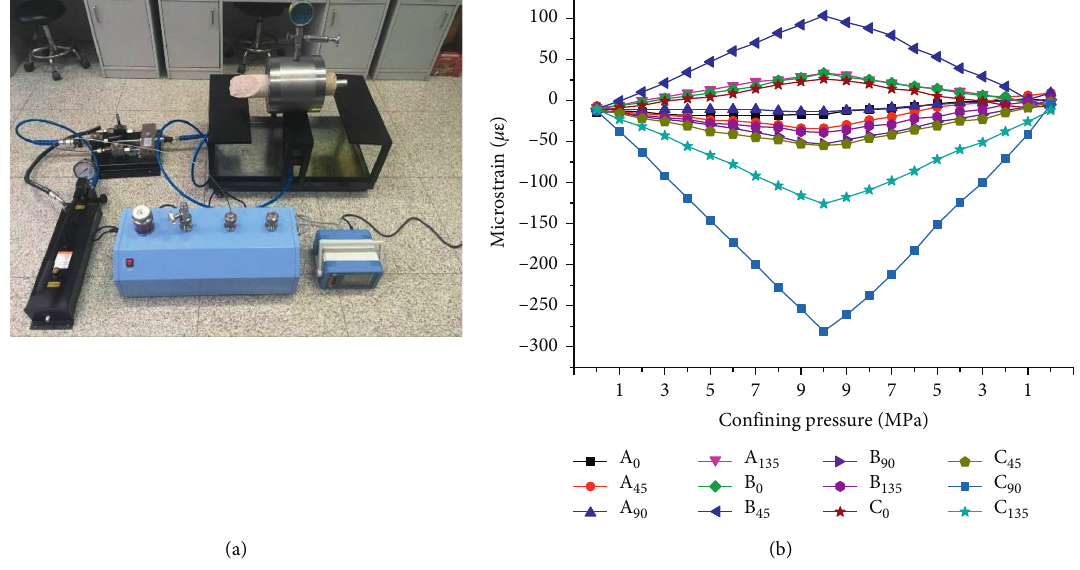
Figure 4: Confining pressure calibration test and its typical testing